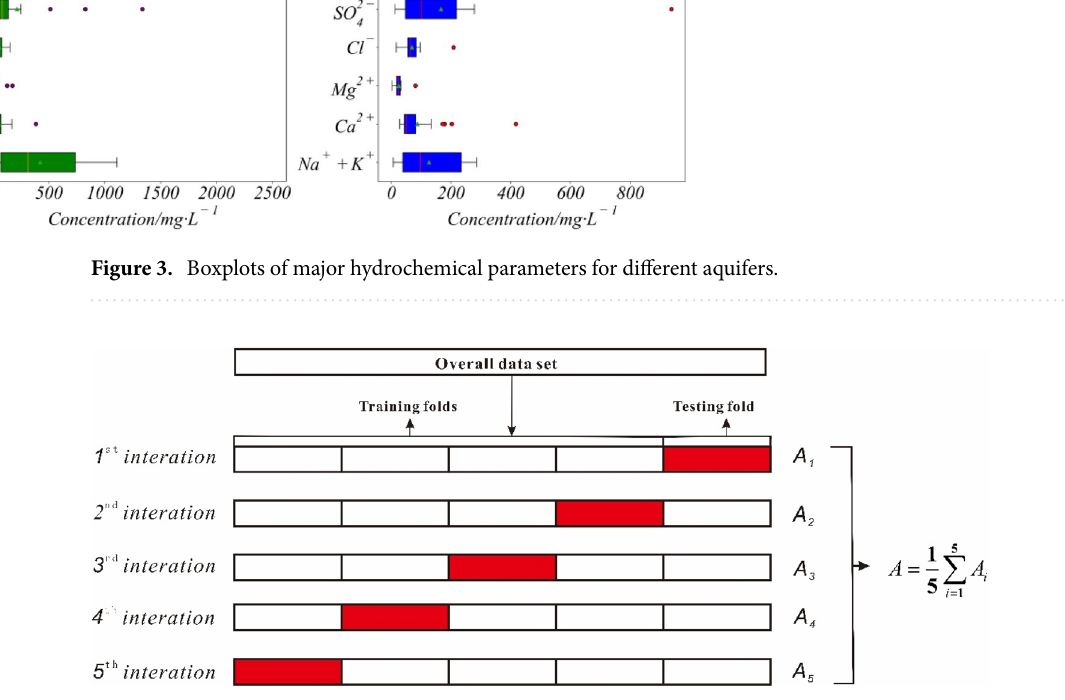
Figure 4. The schematic diagram of Random forests